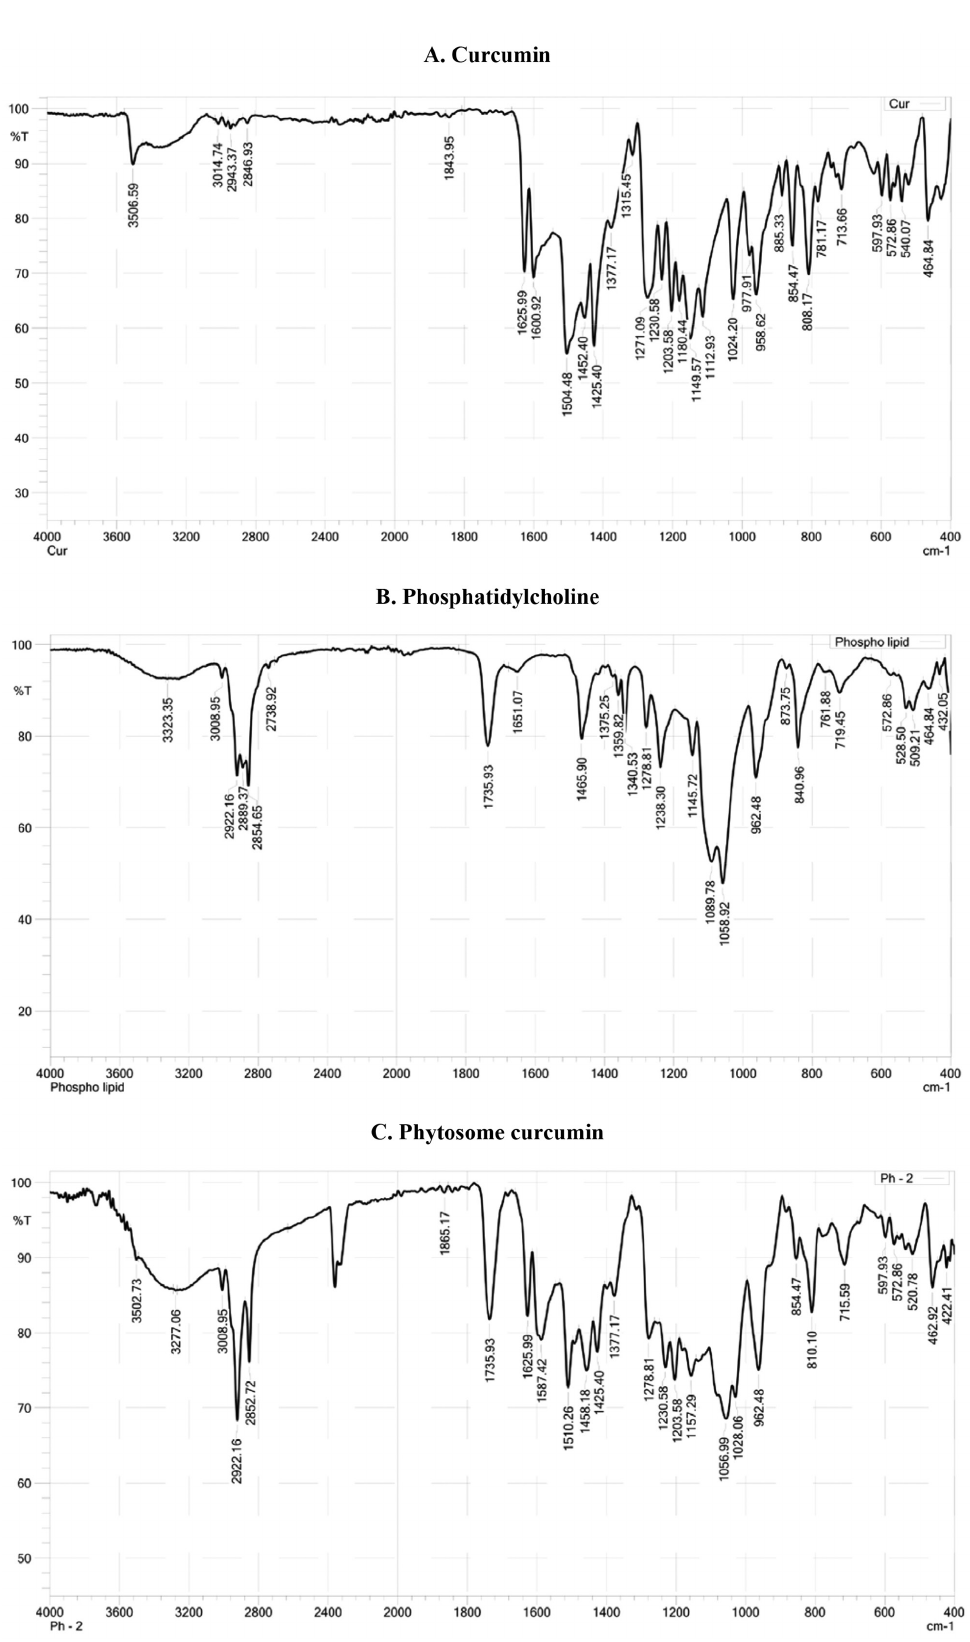
FIGURE 5 - Infrared spectrum of curcumin, phosphatidylcholine and phytosome